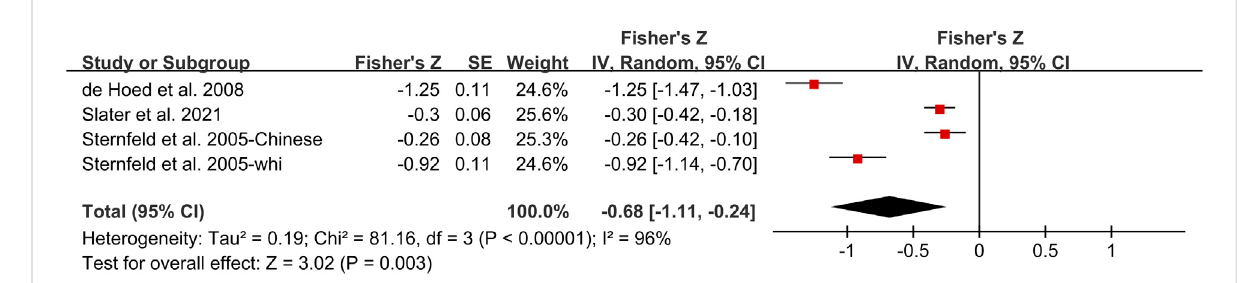
Figure 3), with a high heterogeneity of 90%. Subgroup analysis demonstrated that TPA was signi fi cantly associated with %BF in Caucasian women, but not Paci fi c or Chinese women, with a high heterogeneity (I 2 = 91%, p < 0.001). The high heterogeneity